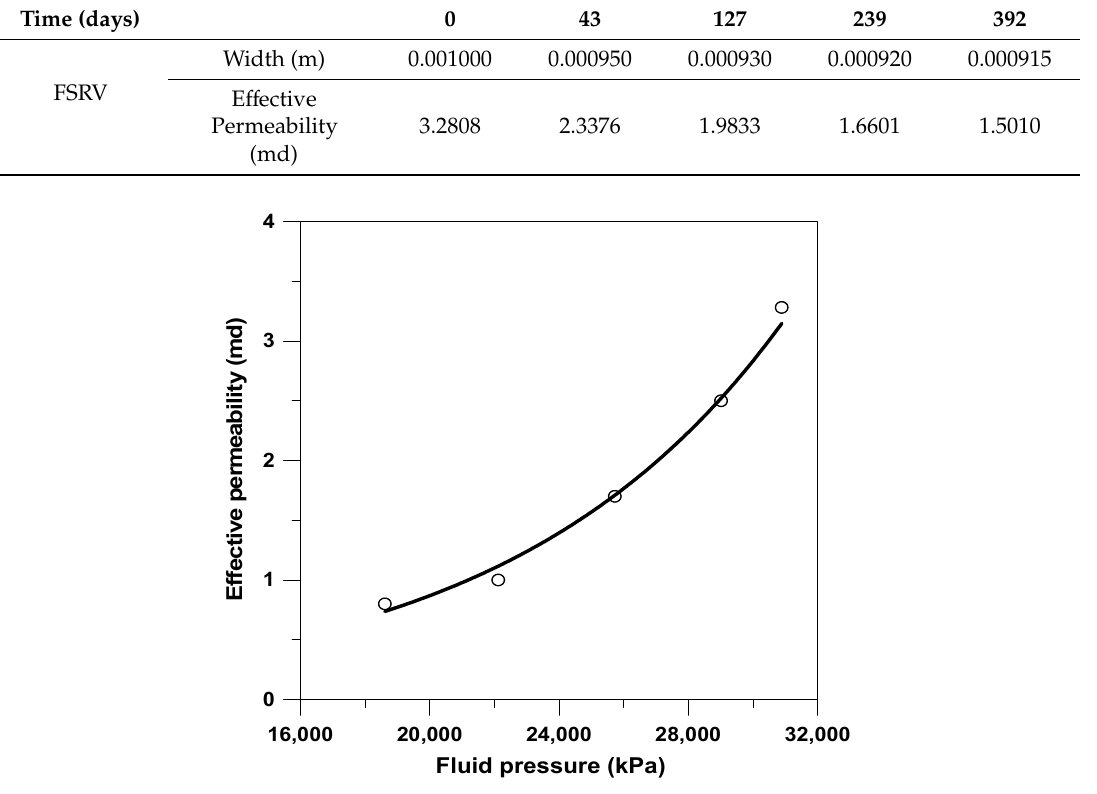
Figure 16. Effective permeability change according to fluid pressure. Table 5. Fracture closure relationship according to fluid pressure change of hydraulic fractures.